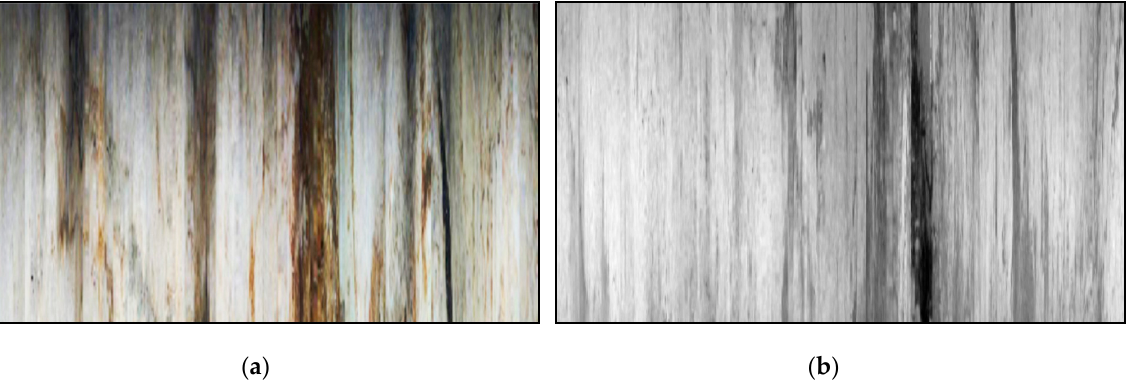
Figure 13. Image comparison before and after well wall fusion. ( a ) Optical image ( b ) processed image.